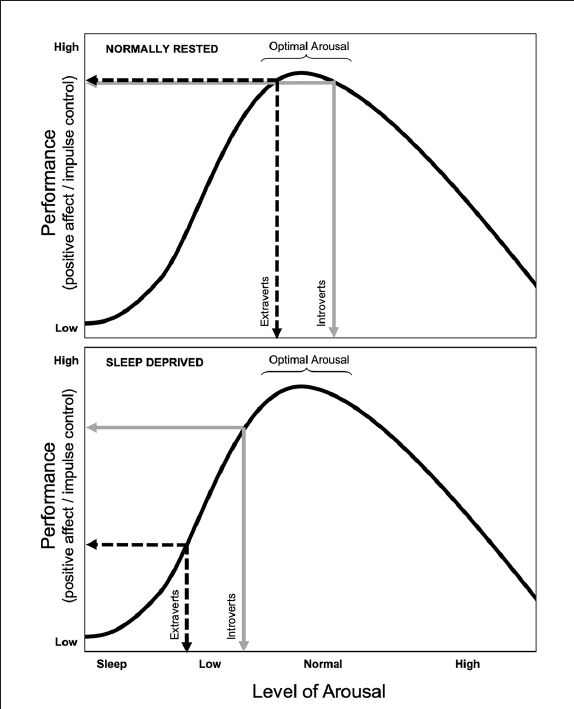
FIGURE4 Diagram of the hypothesized effects of sleep loss (i.e., decreased arousal) on outcome measures (e.g., performance, positive affect, impulse control) based broadly on Eysenck’s theory of cortical arousal (1967, 1981). Top Panel: According to Eysenck’s theory, extraverts (dashed black line) function at a lower level of tonic cortical arousal than introverts (solid gray line); when normally rested, this would be expected to lead to similar levels of performance, positive affect, and impulse control. Bottom Panel: During sleep loss, arousal levels would be expected to decline for both groups equally (i.e., shifting both groups to the left), but would be manifested most noticeably among extraverts, as their tonic arousal exists closer to the left side of the curve than for introverts. This is postulated to lead individuals higher in trait extraversion to show greater mood declines and difficulties regulating suicidal impulses when sleep is